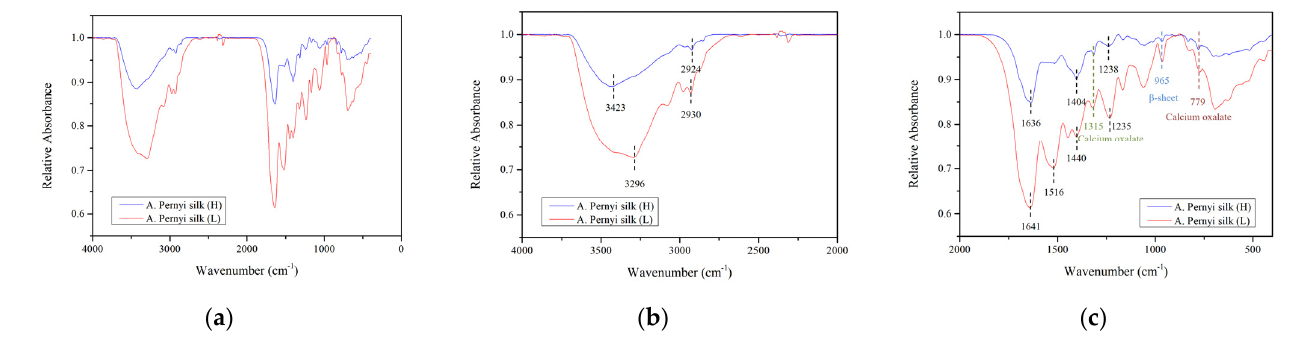
Figure 9. Comparison of FTIR of the A. pernyi cocoons ( a ) in the range 4000 − 400 cm − 1 ; ( b ) in the range 4000 − 2000 cm − 1 ; ( c ) in the range 2000 − 500 cm − 1